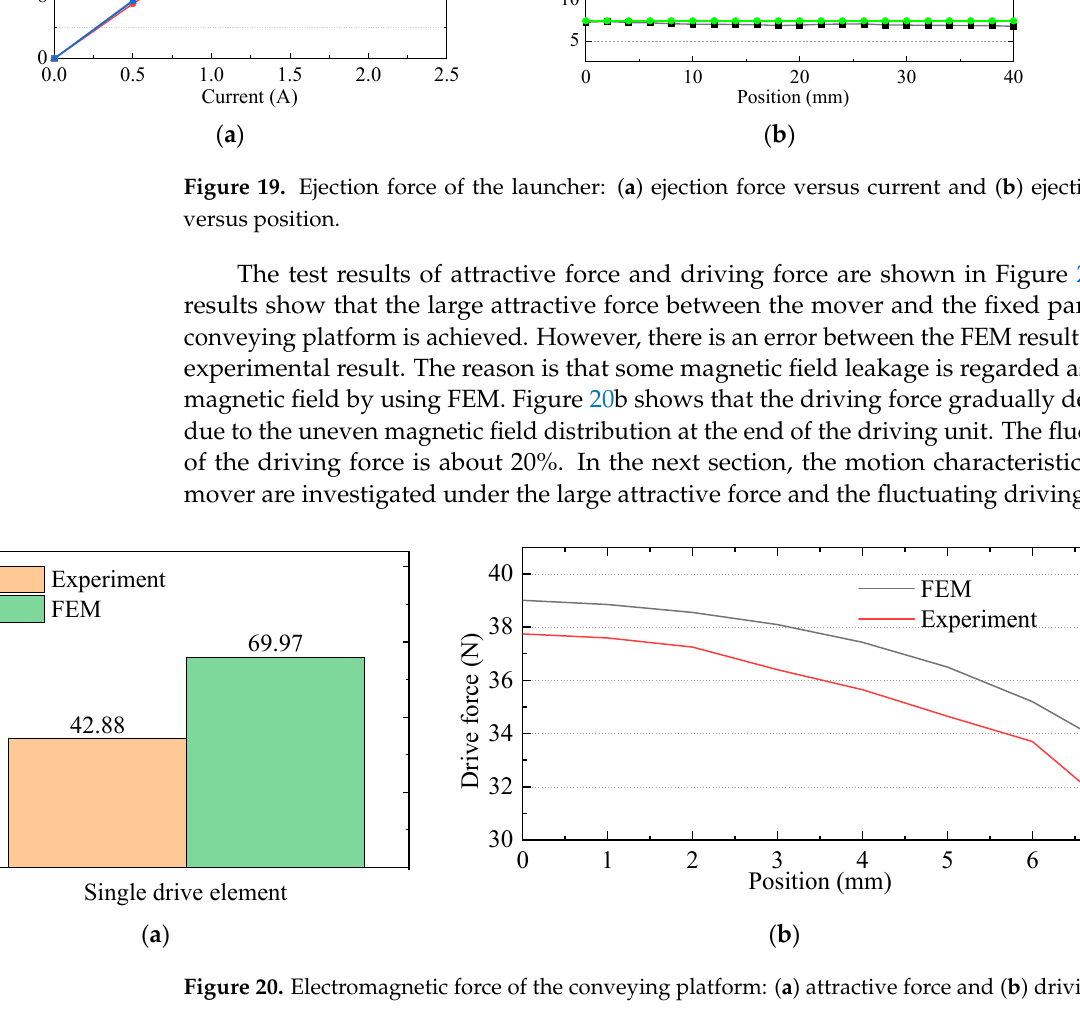
Figure 19. Ejection force of the launcher: ( a ) ejection force versus current and ( b ) ejection force versus position.